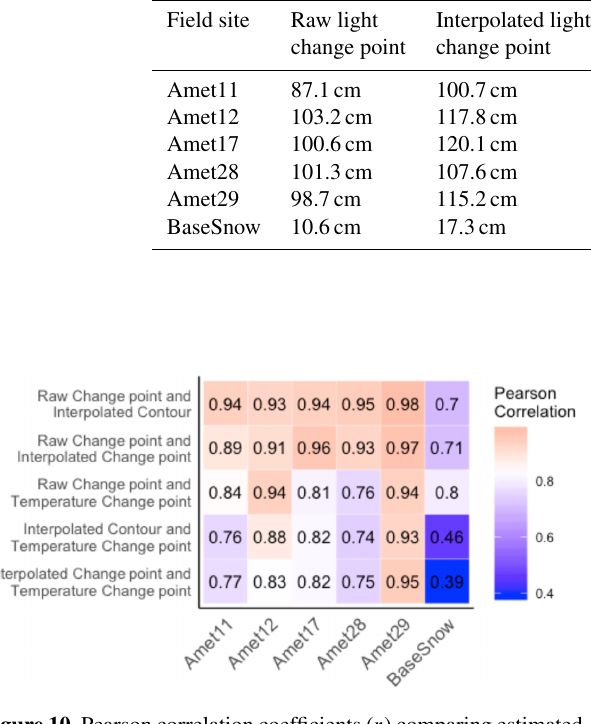
Figure 10. Pearson correlation coefficients ( r ) comparing estimated snow depths from December 2019 and January 2020, between methods for each